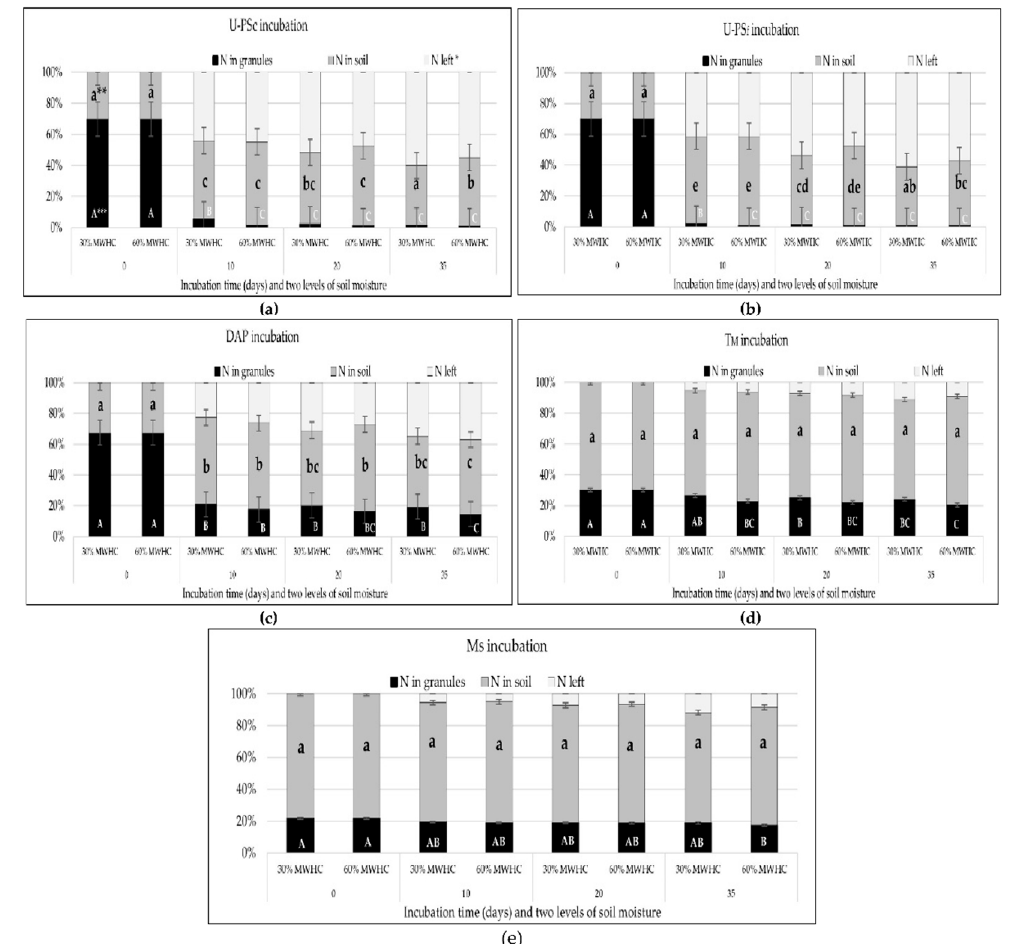
Figure 4 . Nitrogen distribution in soil–fertilizer system throughout incubation time and soil moisture under incubation of mineral ( a – c ) and organic fertilizers ( d , e ); * N left—the nitrogen participation was not detected by Kjeldahl procedure; values are mean ± standard error; ** small (N in soil) and *** capital (N in granules) letters indicate significant difference from one another based on Tukey’s test at p <